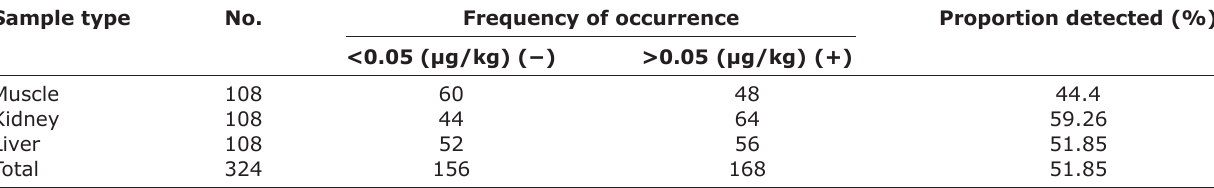
Table-3: Frequency of occurrence of gentamicin residue in different organs (undetected). Sample